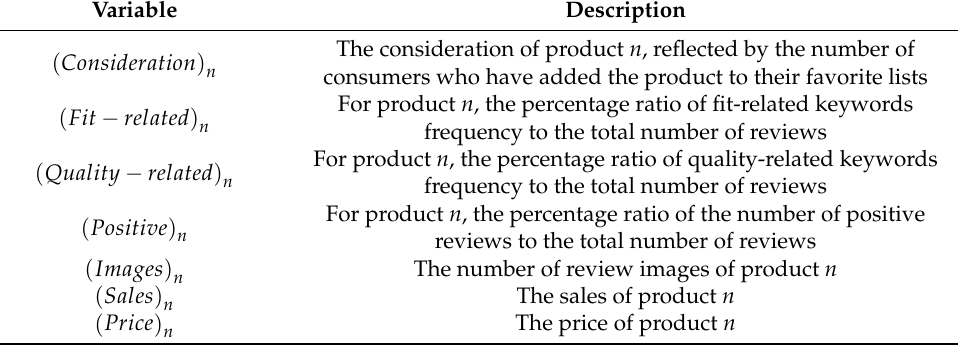
For product n , the percentage ratio of fit-related keywords For product n , the percentage ratio of quality-related keywords